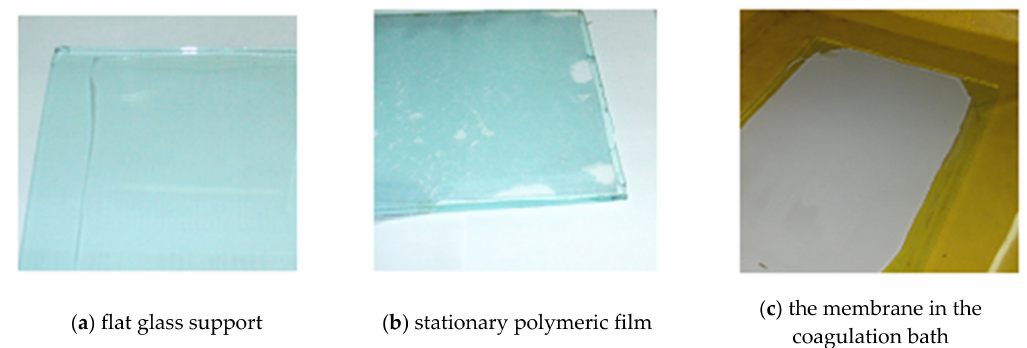
Figure 5. Polymeric film in the studied stage (arrow in Figure 4), between casting ( a ), stationary in the medium ( b ), and coagulation in the bath ( c